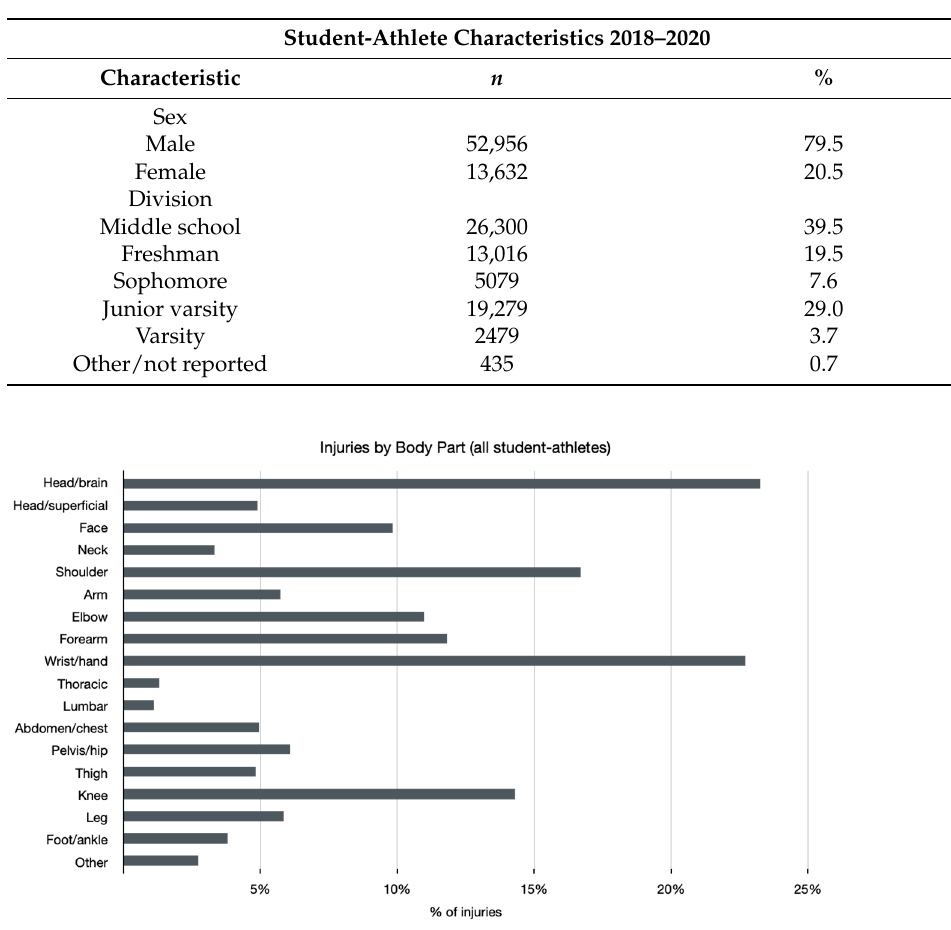
Table 1. Student athlete characteristics. Total n and percentage of student athletes enrolled in the